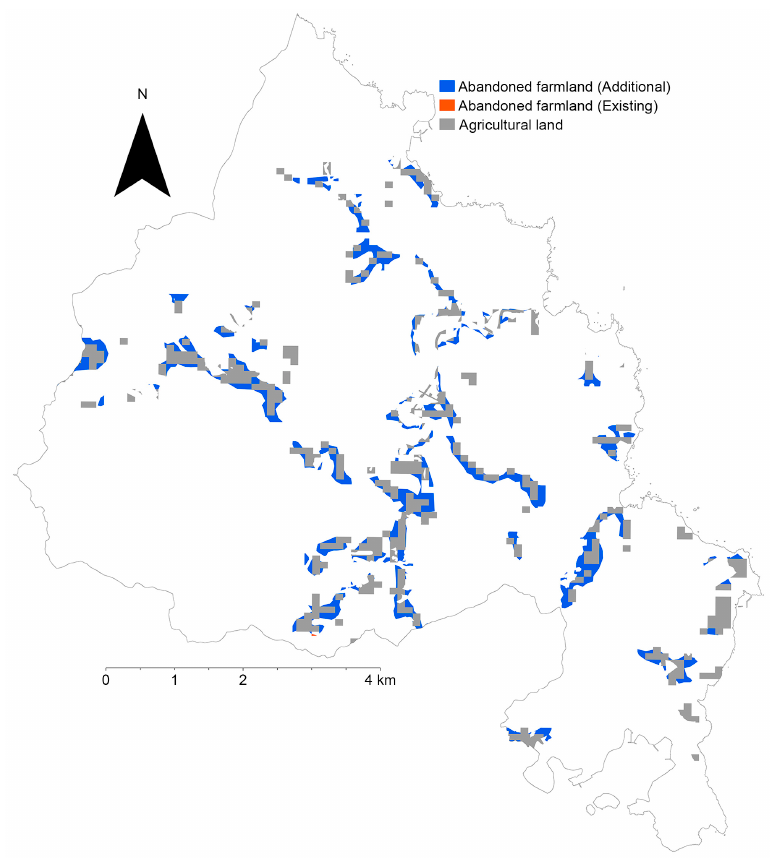
Figure 5. Distribution of abandoned farmland in Ine town. Agronomy 2023 , 13 , 513